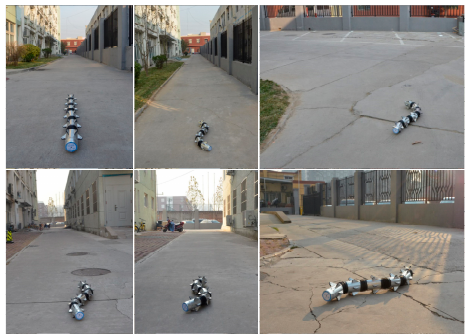
Figure 13. Outdoor experiment.